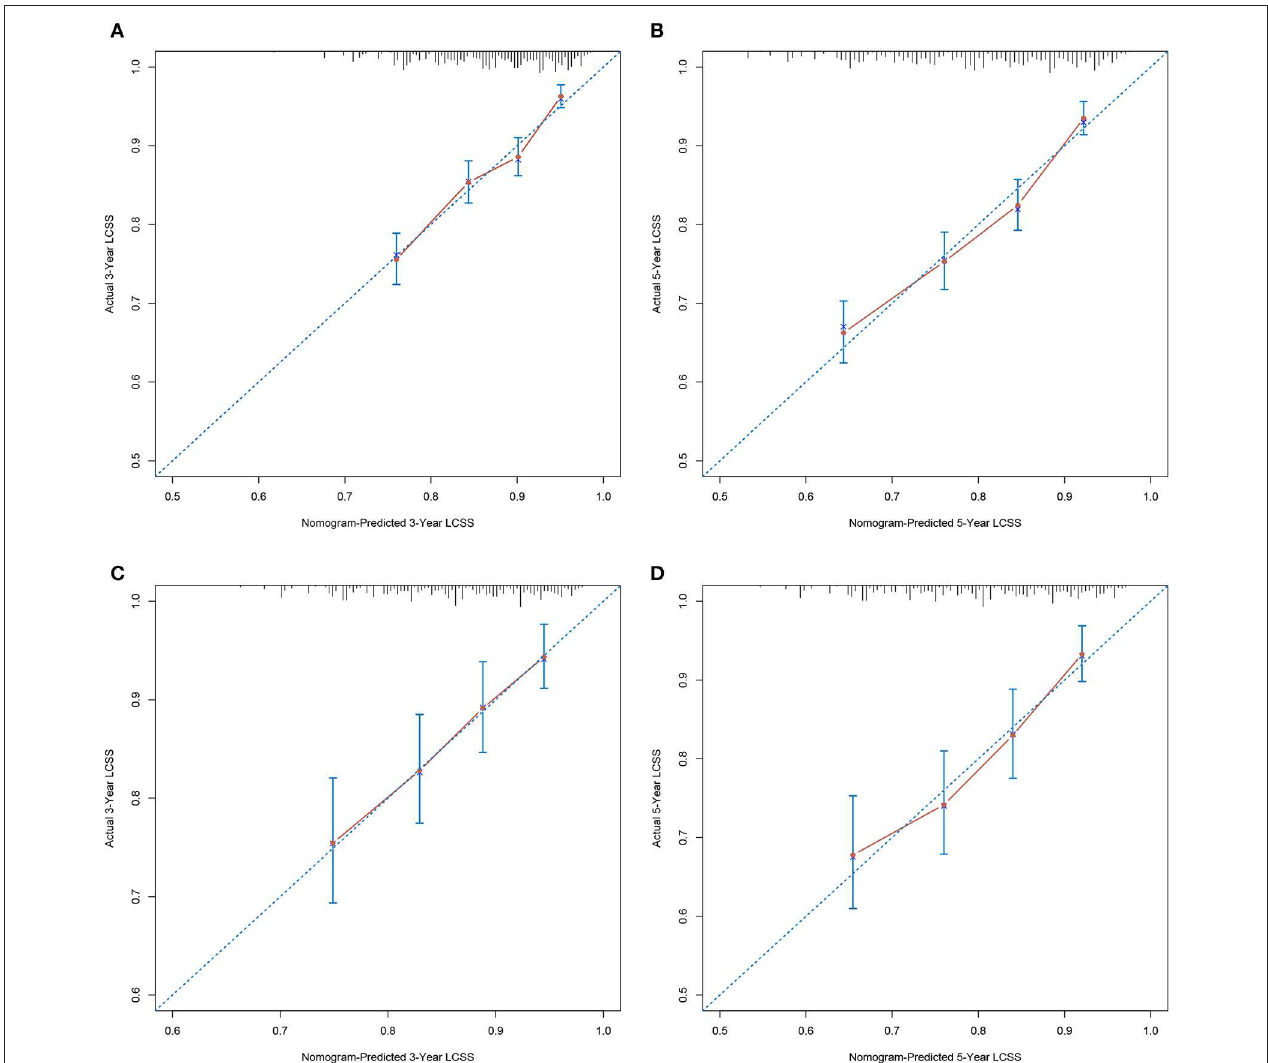
FIGURE 3 | Calibration plots demonstrating the consistency between the nomogram predicted and actual observed 3- and 5-year LCSS in (A,B) development cohort and (C,D) validation cohort. LCSS, lung cancer-specific